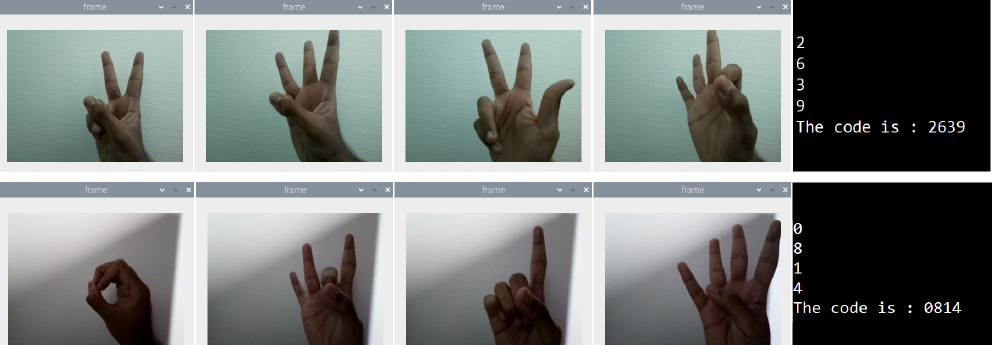
Figure 10. Four Numbers are predicted one after another in real-time under different natural lighting conditions (uniform lighting condition in first row and non uniform lighting condition in second row), where the corresponding sign language images were captured and processed using edge computing device deployed in this work, and the final code that was generated using proposed CNN given as the last image in each